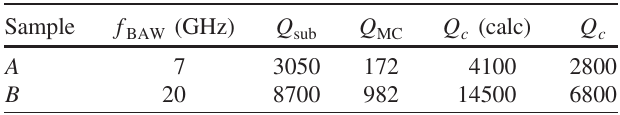
TABLE I. Measured [ Q factors for the comb modes from Eqs. (1) and (2) using d